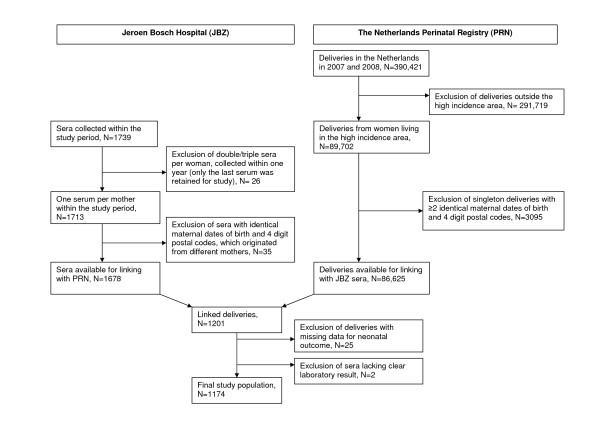
Flowchart of serological analyses and pregnancy outcome.